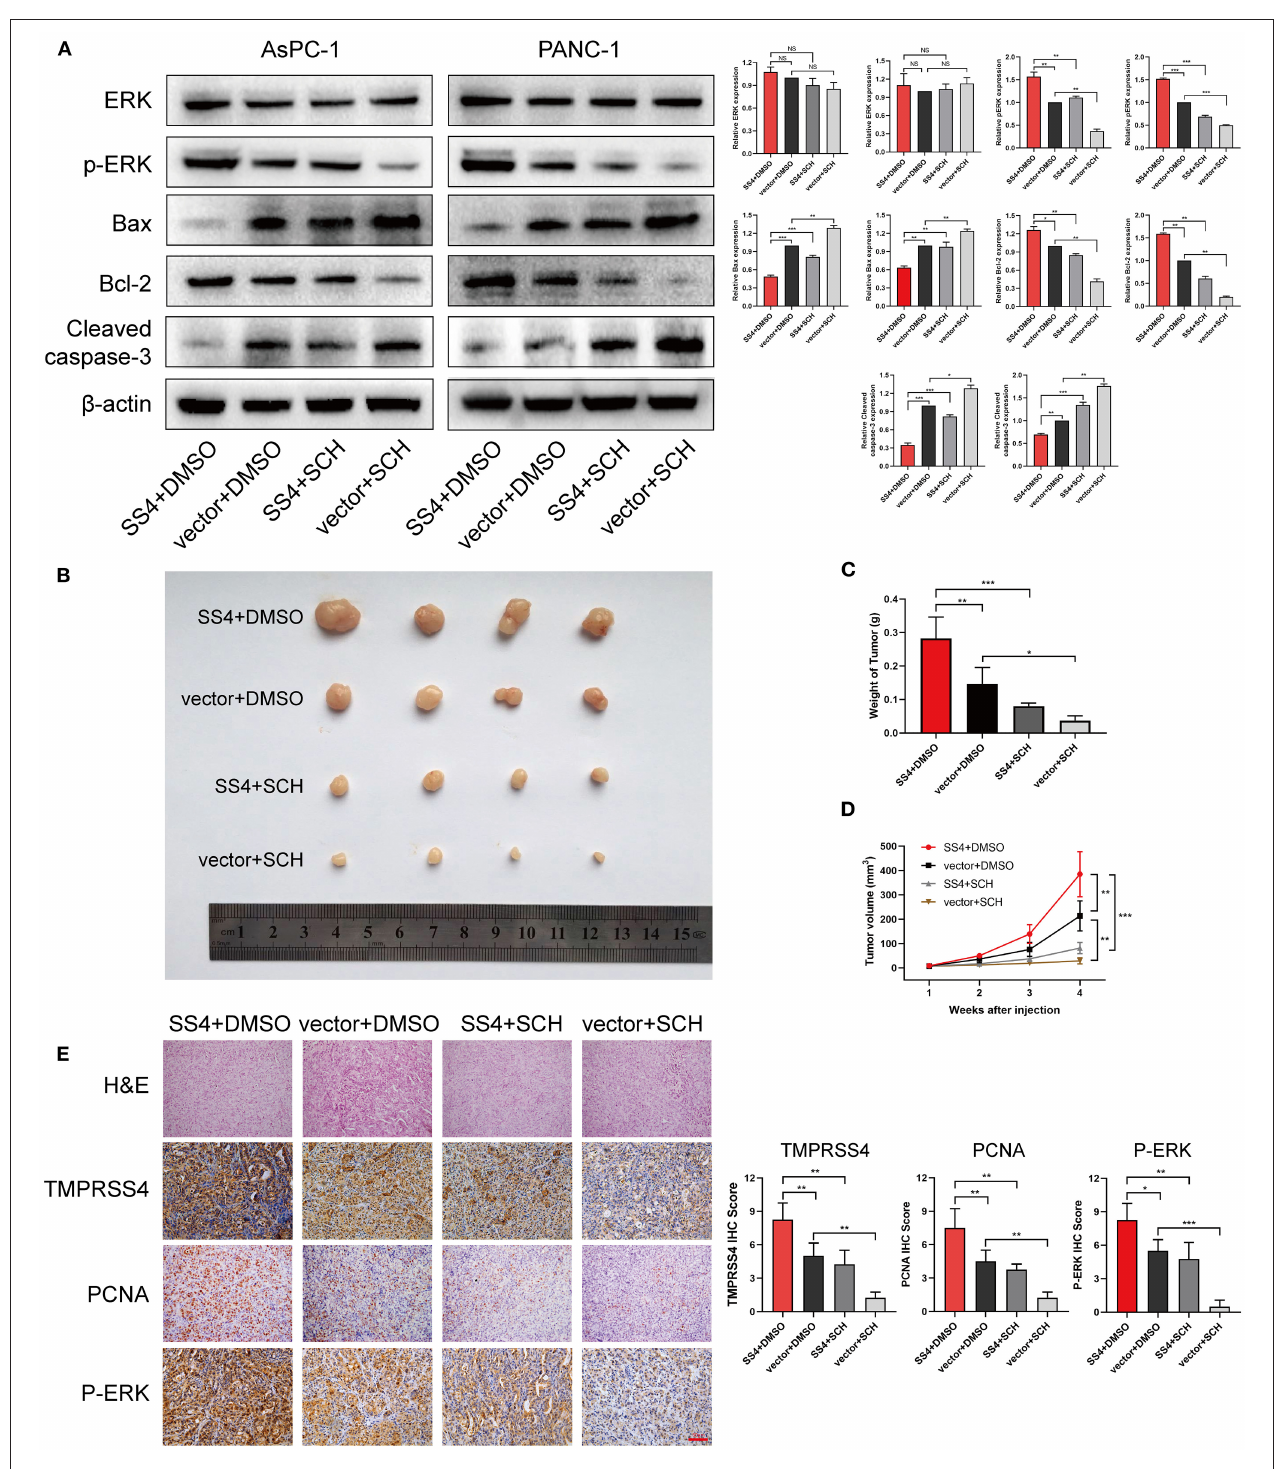
FIGURE 6 | The ERK1/2 signaling pathway is essential for the TMPRSS4-induced cell proliferation in vivo . (A) Western blot analysis of total ERK1/2, phosphorylated ERK1/2, Bax, Bcl-2, and cleaved caspase 3 in the indicated cells. β -actin was used as a loading control. (B) Tumors from four groups of mice. (C) The mean tumor weights. (D) Tumor volumes measured on the indicated days. (E) HE and IHC staining on tumor tissues. 200 x. Each bar represents the mean ± SD. Paired Student’s t -test was applied. Student’s t -test (for two groups) or ANOVA with Turkey’s method (for several groups) were used for comparisons. * P < 0.05; ** P < 0.01; HE, Hematoxylin and Eosin; IHC, immunohistochemistry; PCNA, Proliferating Cell Nuclear Antigen.